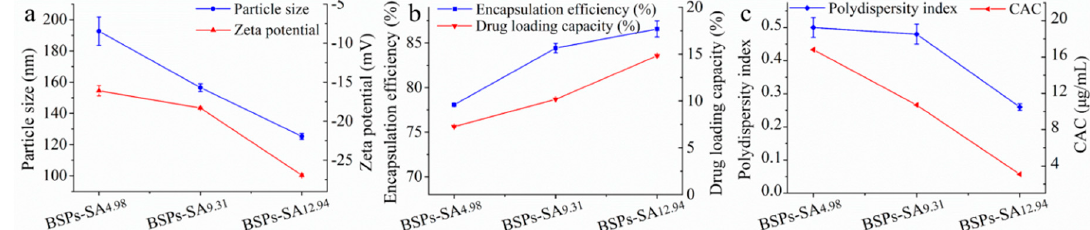
Figure 2. The effects of the degree of substitution (DS) values of stearic acid moieties on particle size and zeta potential ( a ), encapsulation efficiency and drug-loading capacity ( b ), and polydispersity index values and critical aggregation concentration (CAC) values ( c ) of BSPs-SA nanoparticles. Data are shown as mean ± SD. ( n = 3).